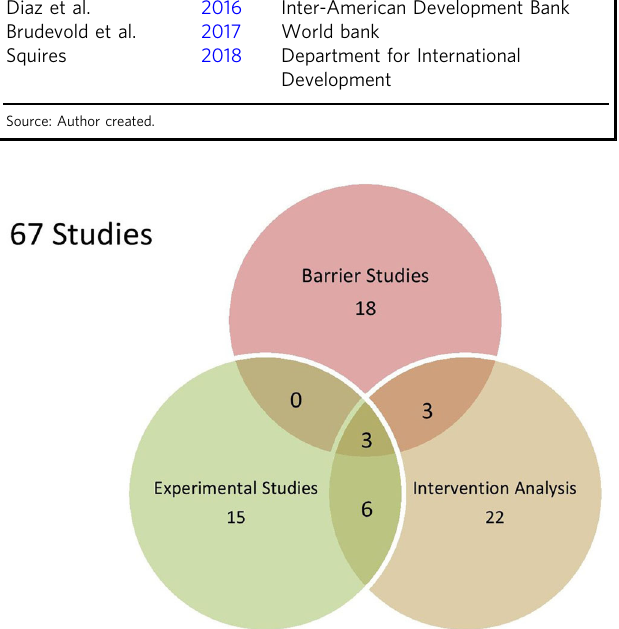
Fig. 2 Classi fi cation of selected studies. Venn grouping of the selected studies on the basis of their evaluation of barriers or interventions and the nature of study being experimental or otherwise (author created).